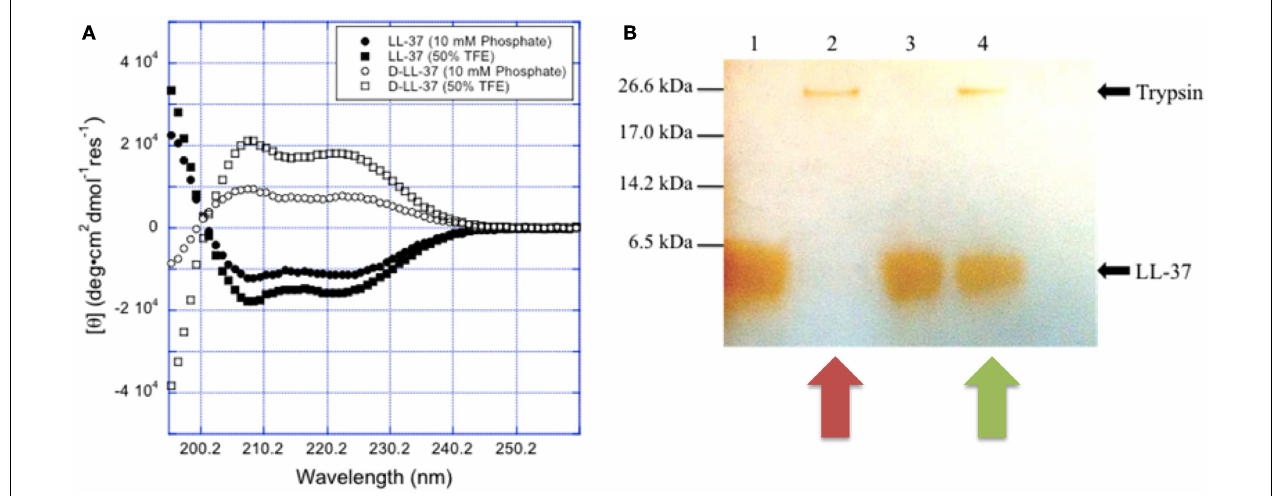
membrane-mimics.These results are consistent with what has been reported in the literature for these peptides. (B) d-LL-37 demonstrated resistance to degradation by trypsin. Peptides (18 µ g) were dissolved in water (90 µ L) with either water or 0.05% trypsin (10 µ L) and incubated (37 °C, 1h).Ten microliters of aliquots were separated on SDS-PAGE, and a silver stain was performed. Lane 1, LL-37; Lane 2, LL-37 with trypsin; Lane 3, d-LL-37; Lane 4, d-LL-37 with trypsin. (Figure from Dean et al., 2011a, used with